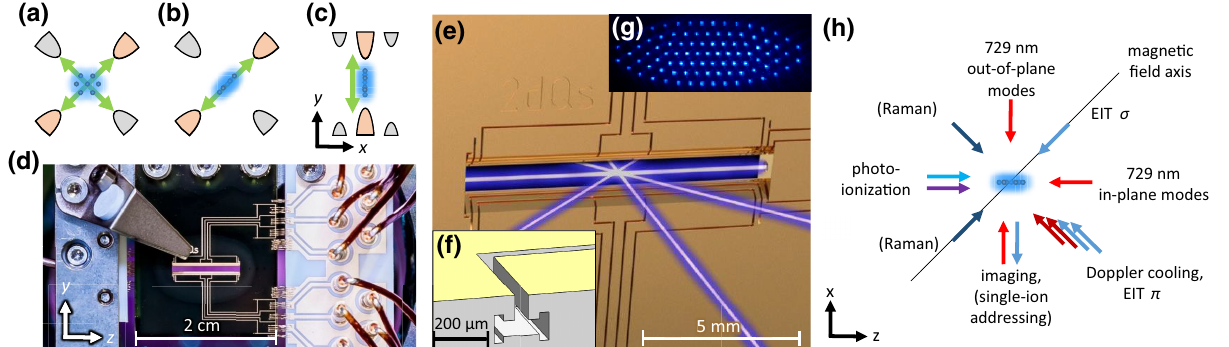
FIG. 1. (a),(b) Radial cross section of a linear Paul trap. The orange (gray) shapes symbolize rf (dc) electrodes. The green arrows denote the directions of micromotion experienced by the ions in the crystal (blue). In (a), the planar crystal is oriented in the plane spanned by the radial directions of the trap, and in (b), it is oriented in the plane spanned by one radial direction and the axial direction. (c) Radial cross section of a three-layer trap. This geometry allows optical access perpendicular to micromotion. (d) Photograph of the ion trap inside the vacuum chamber. The trap chip is seen in the center of the picture. Ions are loaded from a calcium target, attached to a funnel aperture (top left). Two printed circuit boards made of alumina (front right and rear left of the trap chip) provide interfaces between gold wirebonds to the trap electrodes and cables to the vacuum feedthroughs. (e) Three-dimensional rendering of the central region of the ion trap (rear side with rf electrode leads) and laser beams in the horizontal plane. (f) The trench geometry, used to electrically isolate electrodes. The electrode separation on the surface of the trap chip is 50 µ m. (g) A Coulomb crystal consisting of 91 40 Ca + ions stored in the center of the trap. (h) Top view of the laser beam and magnetic field geometry in the horizontal plane. Parentheses indicate beams that have not yet been implemented. Not shown are two laser beams that do not lie within the horizontal plane: a 729-nm beam for spectroscopy of in-plane and out-of-plane motional modes that has an angle of 45 ◦ with the horizontal plane, and a second cooling beam at an angle of approximately 20 ◦ with the horizontal plane coupling also to the vertical